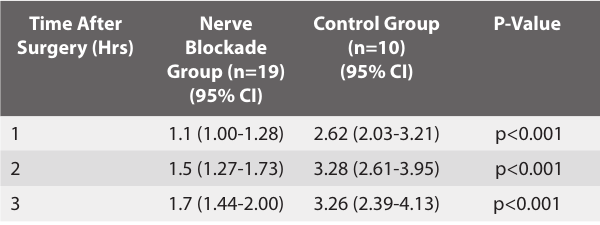
Table 3. Subgroup analysis of postoperative pain scores in FESS groups* Comparison of pain levels 1-3 hours postoperatively in nerve blockade intervention group with control group.